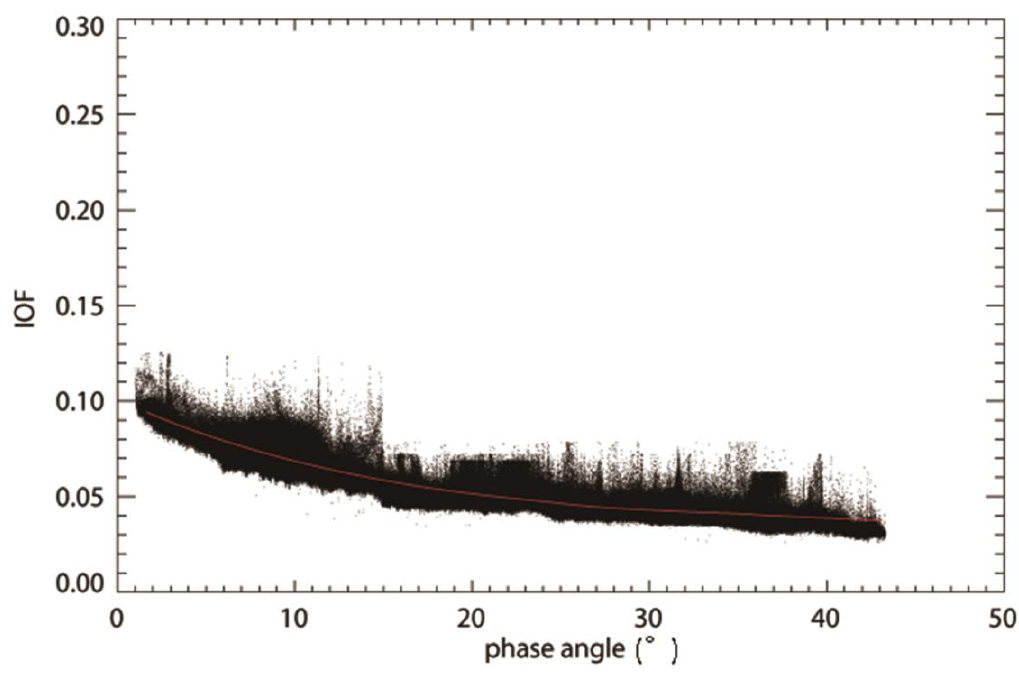
Figure 6. The phase functions of the sample data for the 757 nm band. The red curve represents the Hapke model we